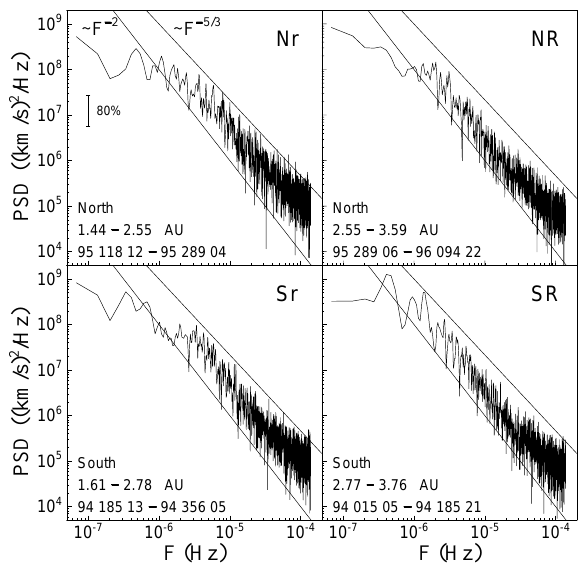
Fig. 2. Power spectral density (PSD) of the velocity fluctuations versus the frequency F . Panels Nr and NR (Sr and SR) are for the inner and outer region of the northern (southern) polar wind, respec- tively. Radial range and time interval are indicated in each panel. Straight lines are drawn to indicate the F − 5 / 3 and F − 2 scalings. An 80% confidence bar is shown in panel